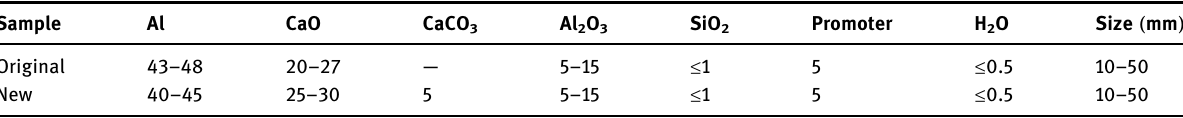
Table 1: Compositions of the original and new modi fi ers ( % ) Sample